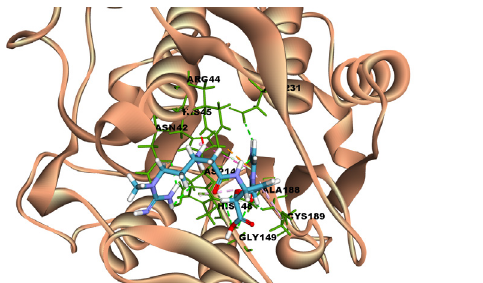
Fig. 2B. 3D diagram showing interactions of Blastici- cidn S hydrochroideat LGMN catalytic